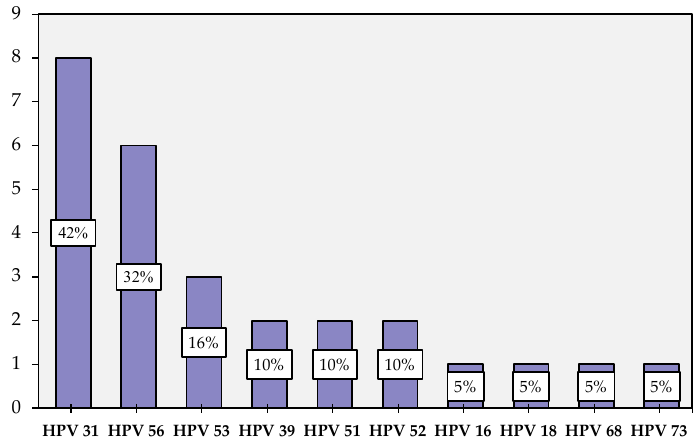
Figure 1. Frequencies of HR-HPV types.